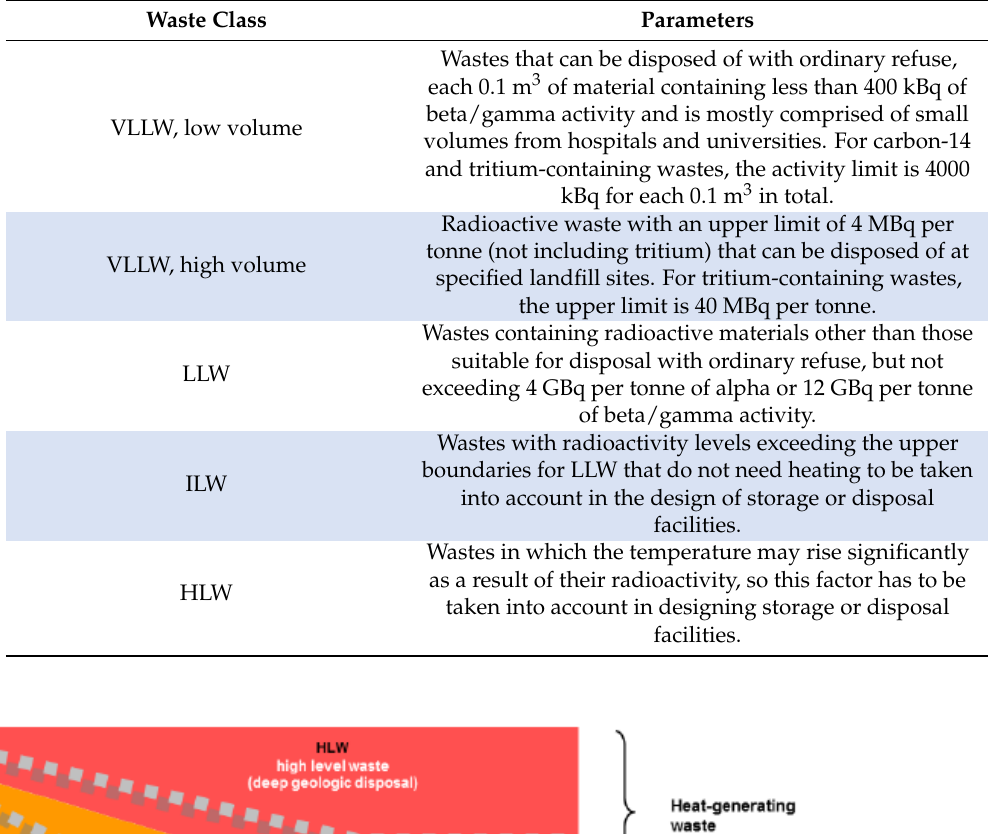
Table 1. Classification of radioactive waste in the UK.